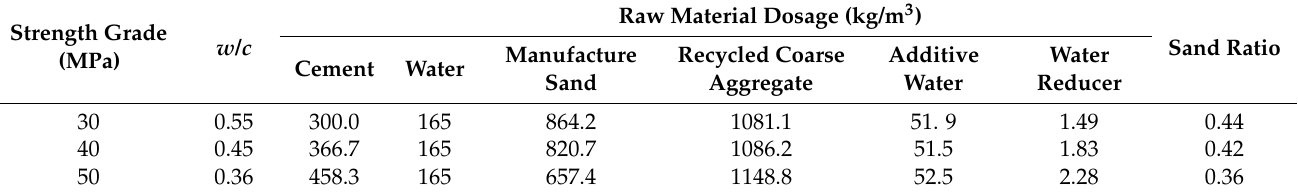
Table 2. Results of mix proportion of RAMC.